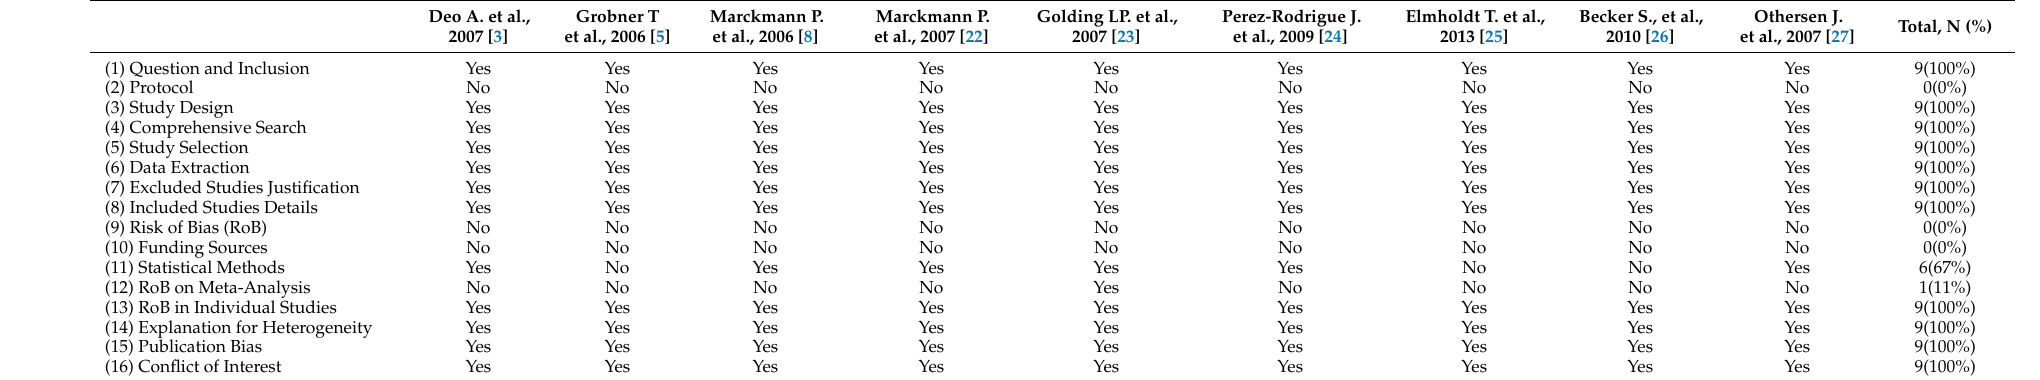
Table 4. Summary of the AMSTAR 2 quality